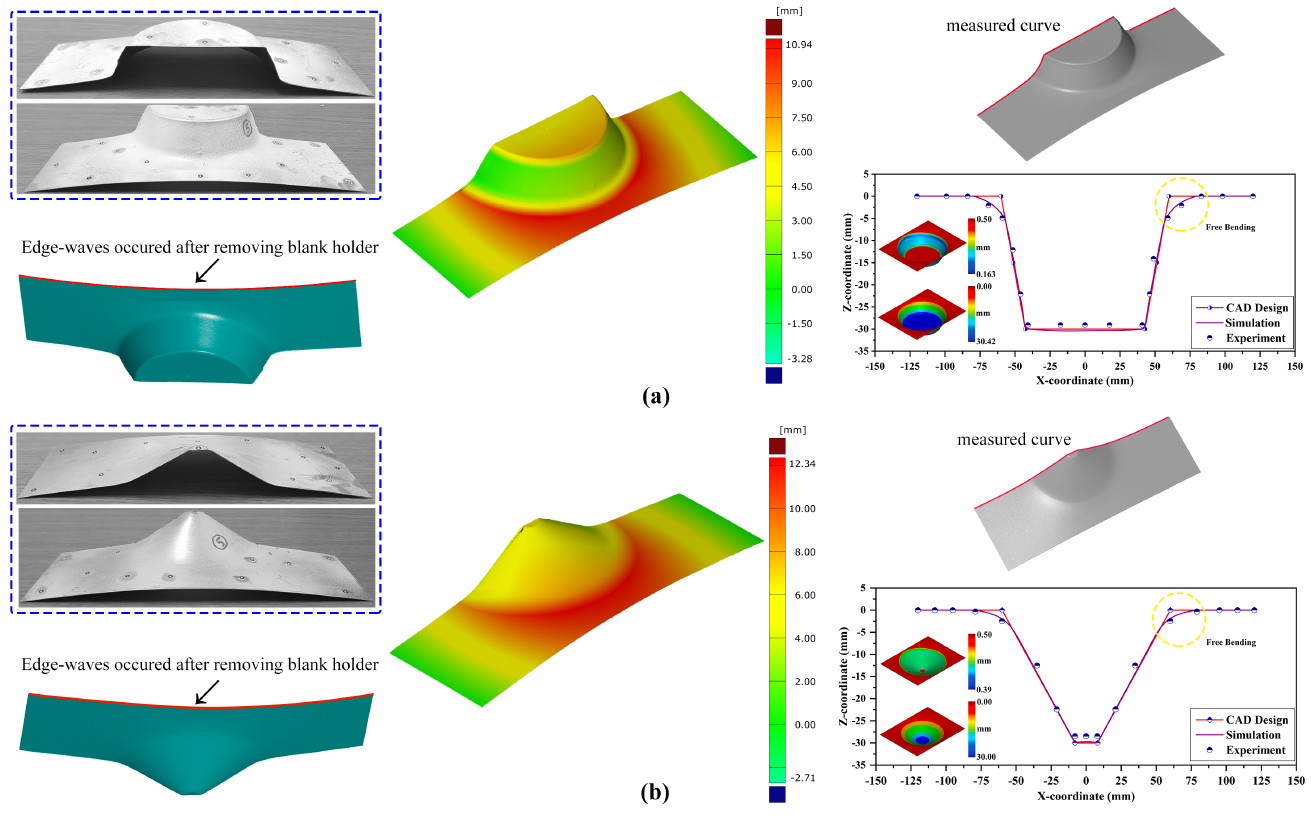
Figure 9. Estimated shape error using the ATOS 3D scanner. ( a ) 60°; ( b ) 30°.